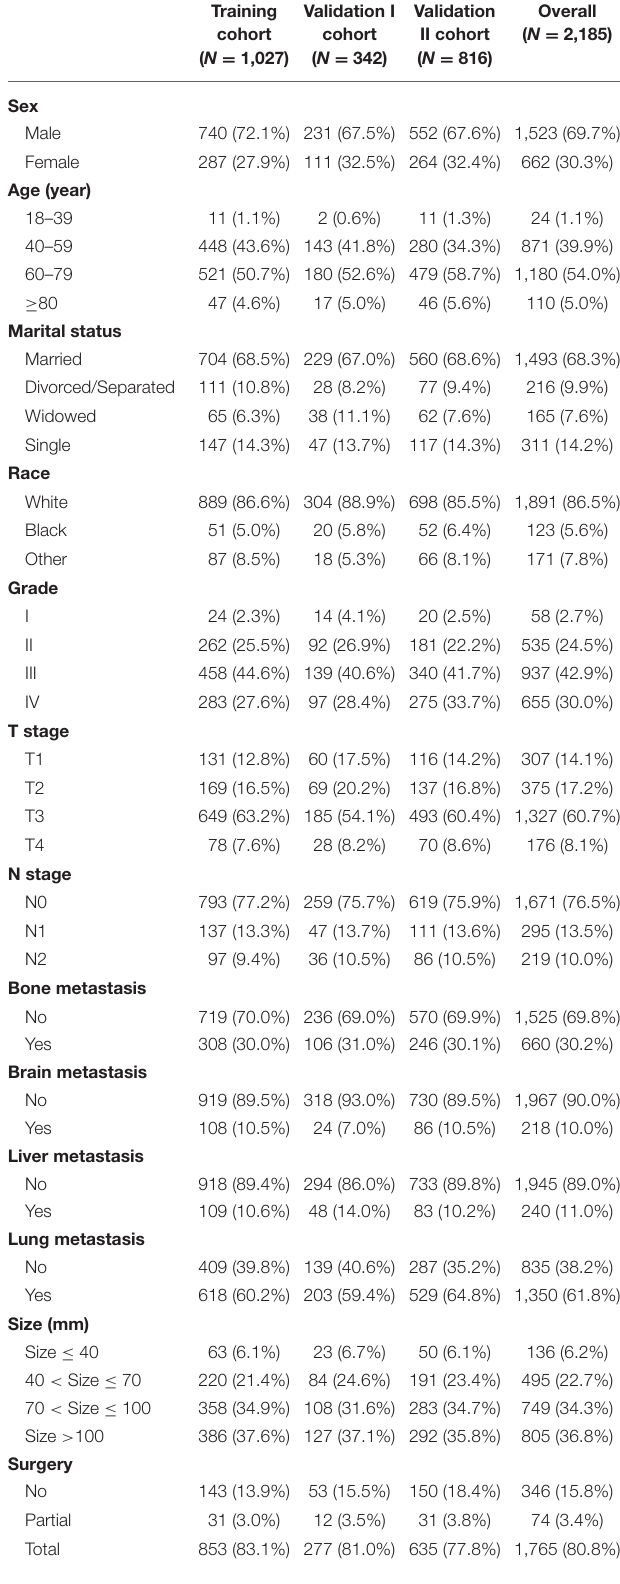
TABLE 1 | Demographic and clinical characteristics of ccRCC patients with distant